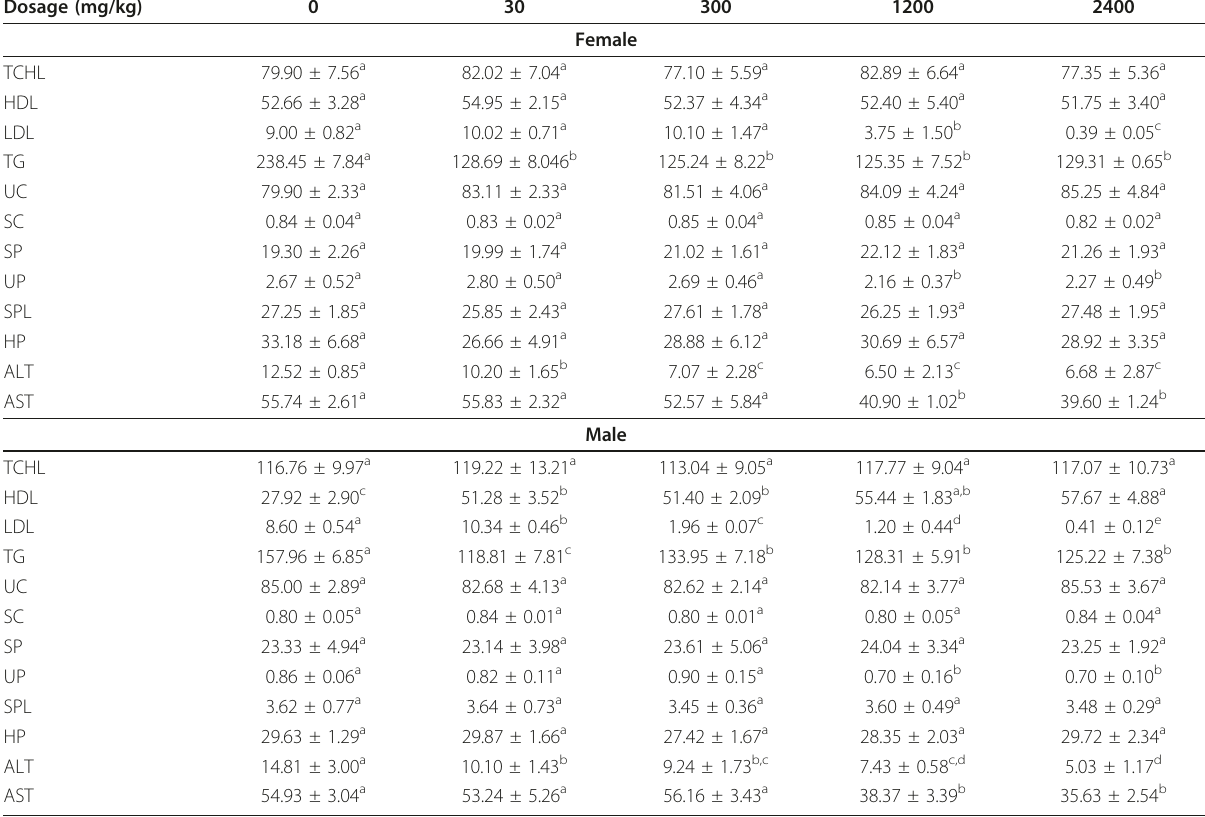
Table 4 Biochemical parameters of rats in sub-acute toxicity of the ethyl acetate extract from Crassocephalum bauchiense as a function of treatment dose Dosage